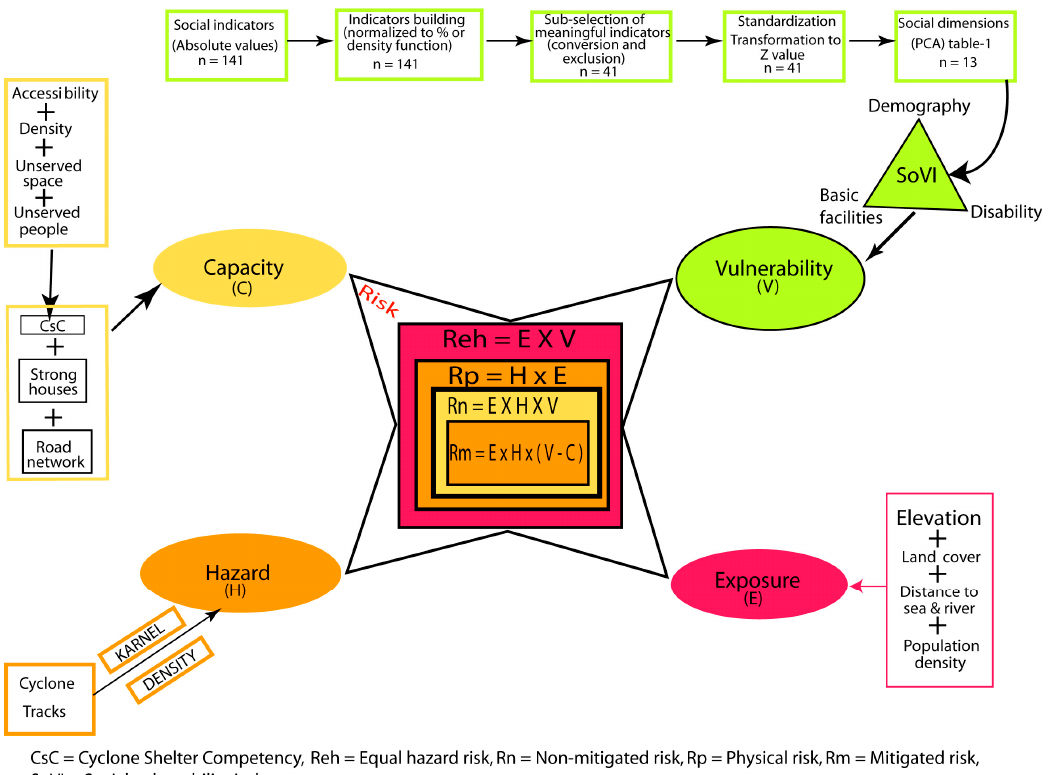
Figure 3. Flow diagram of methods of risk assessment. “ n ” means the number of variables used.